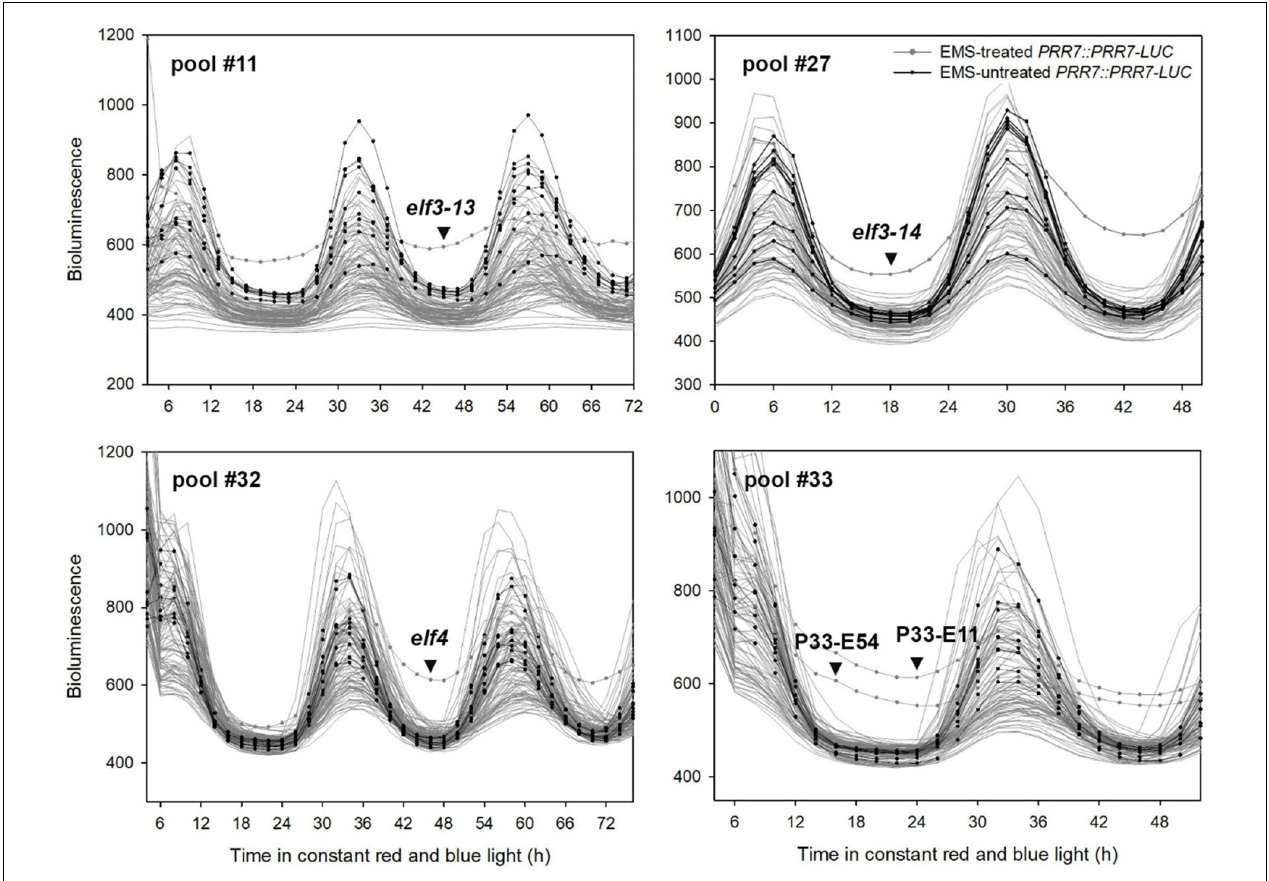
FIGURE 2 | Representative PRR7 turnover factor candidates. The EMS-mutagenized PRR7::PRR7-LUC M 2 seedlings were grown on MS media in 12L:12D white-light cycles for 5 days and transferred to continuous red and blue light (30 µ mol m − 2 s − 1 ) for imaging. Luminescence signals obtained from seedlings grown on the same MS plate were plotted together. Non-EMS-treated PRR7::PRR7-LUC seedlings were included to estimate variability of luminescence signals of the M 2 seedlings. The selected candidates showing increased PRR7-LUC signal are indicated by an arrowhead. Candidates from pool #33 remain